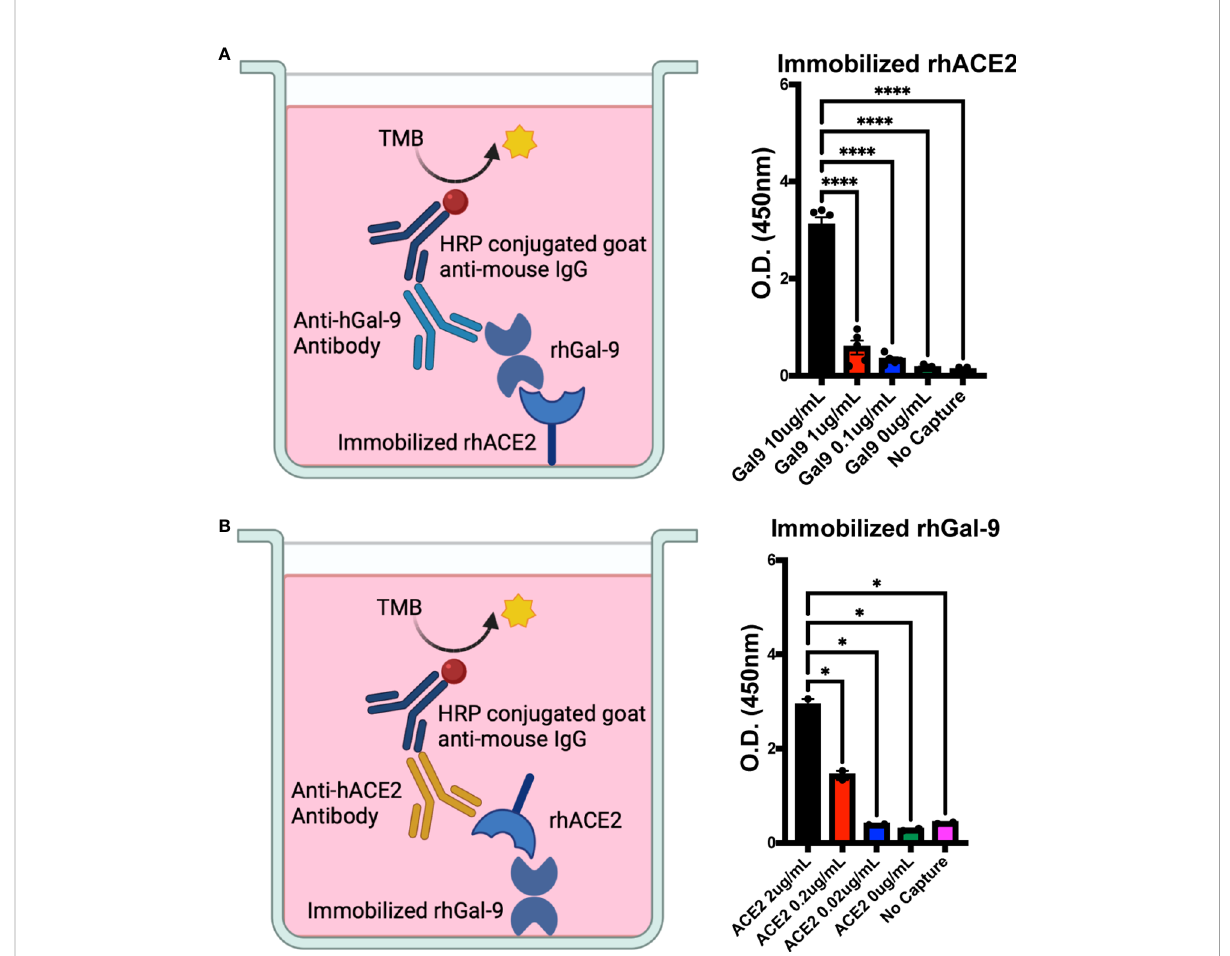
FIGURE 1 Human galectin-9 binds to the human ACE2 receptor. (A) Binding potential of recombinant human galectin-9 (rh-gal-9) to immobilized recombinant human ACE2 (rh-ACE2). (B) Binding potential of rh-ACE2 to immobilized rh-gal-9. n = 2-5/group, *p<0.05 and ****p<0.0001. One-Way ANOVA. Data are represented as mean +/- SEM. TMB= chromogenic substrate 3,3 ’ ,5,5 ’ -Tetramethylbenzidine; HRP= horseradish